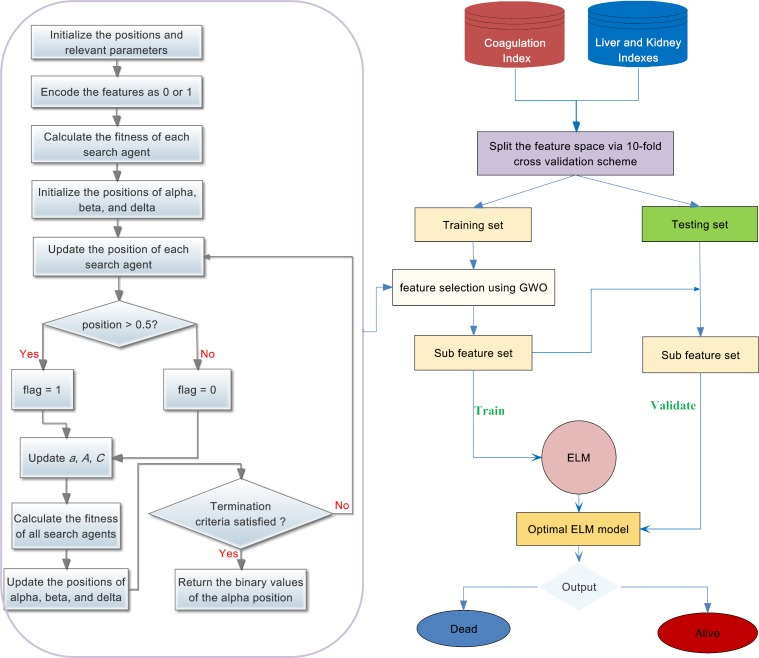
Flowchart of the proposed method.